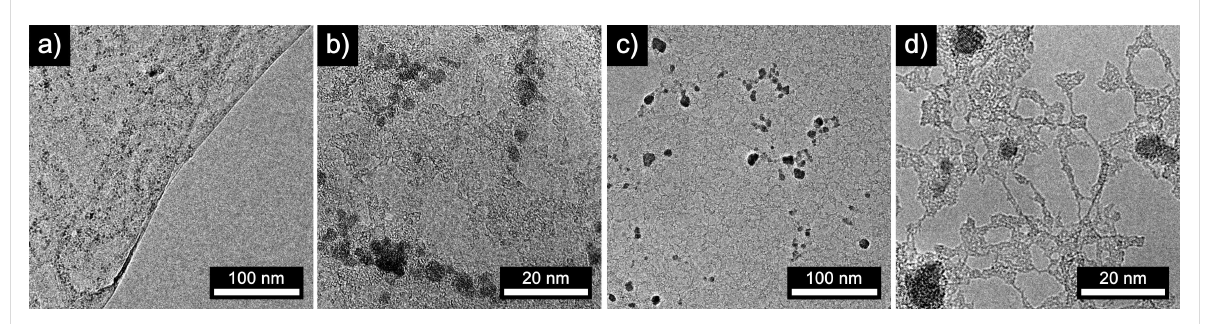
Figure 5: TEM micrographs of iron oxide nanoparticles on graphene; a,b) before and c,d) after thermal annealing at 450 °C for 24 h in a hydrogen at- mosphere. The nanoparticles are highly mobile and tend to agglomerate during the heat treatment procedure.